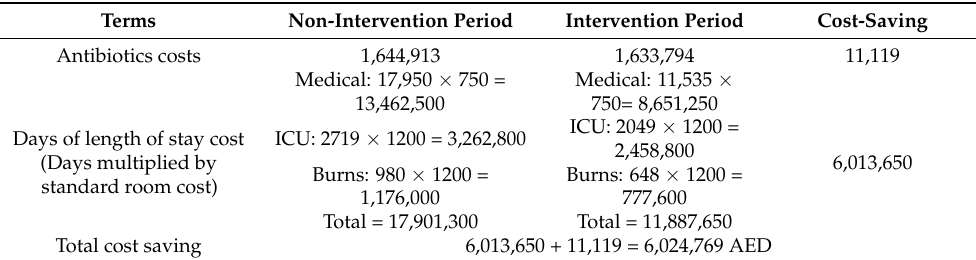
Table 5. Cost saving analysis (AED) comparing the non-intervention group with the intervention